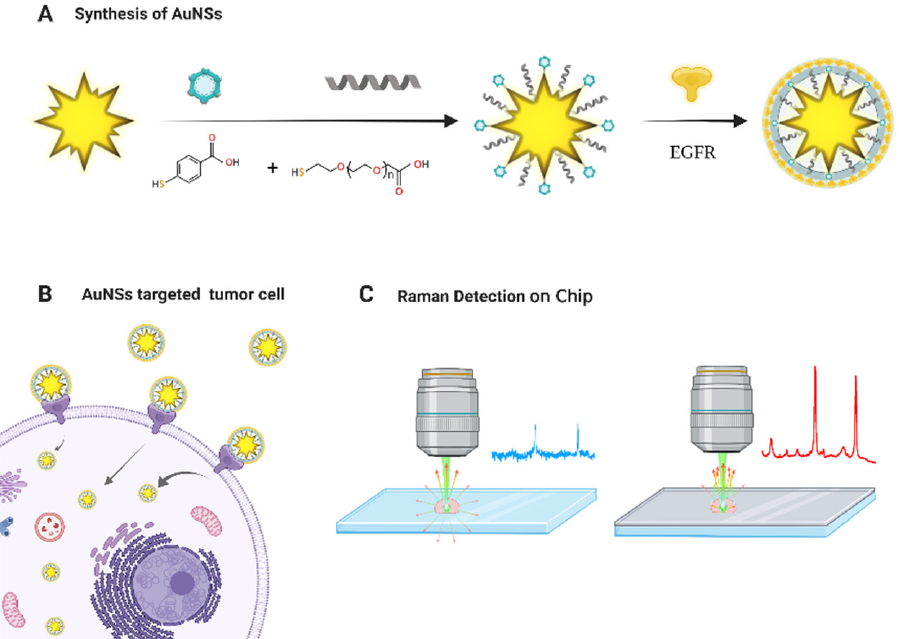
Figure 1. Schematic illustration of the dual-enhanced SERS probe technology in the diagnosis of tumor cells in vitro. ( A ) synthesis od AuNSs; ( B ) AuNSs targeted tumor cell; ( C ) Raman detection on chip.